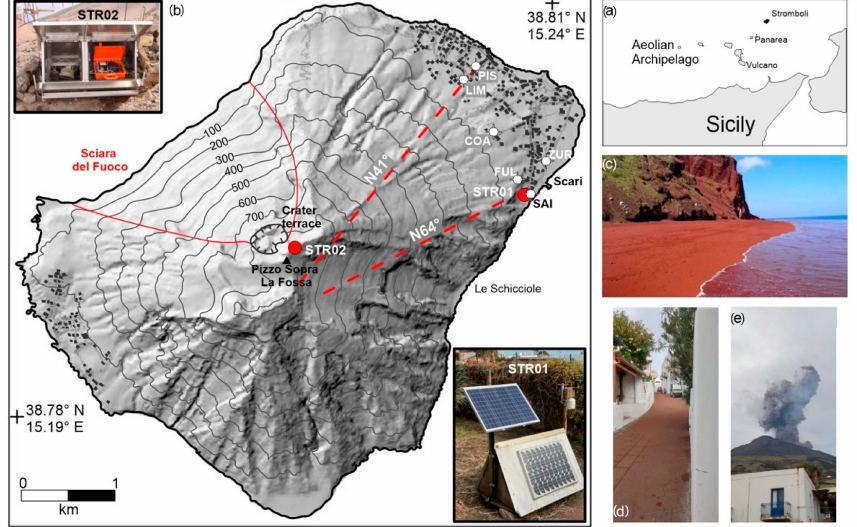
Figure 1. ( a ) Location of the study area. ( b ) Map of Stromboli island with location of wells (white circle), Fulco (FUL), Saibbo (SAI), Zurro (ZUR), COA, Limoneto (LIM), Piscit à (PIS); soil CO 2 moni- toring stations STR01 and STR02 (red circles; photos in the insets); main tectonic lineaments of active fault N41 ◦ and N64 ◦ (red dashed lines). ( c , d ) Reddish ash deposits from the 16 November 2020 major explosion on Le Schicciole beach and along the streets of the Stromboli village. ( e ) Eruptive column of the 16 November major explosion. Photos courtesy of the association AttivaStromboli (www.attivastromboli.net, accessed on 30 March